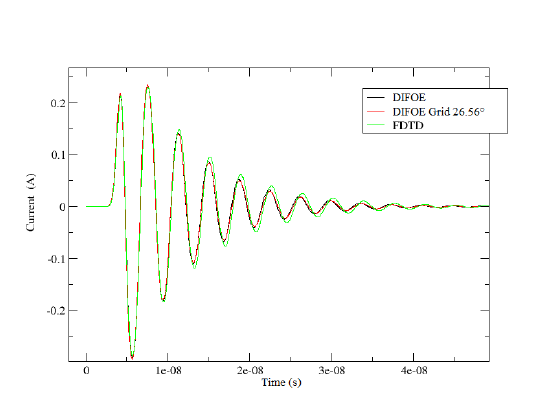
Figure 8: Field versus time close to the wire.